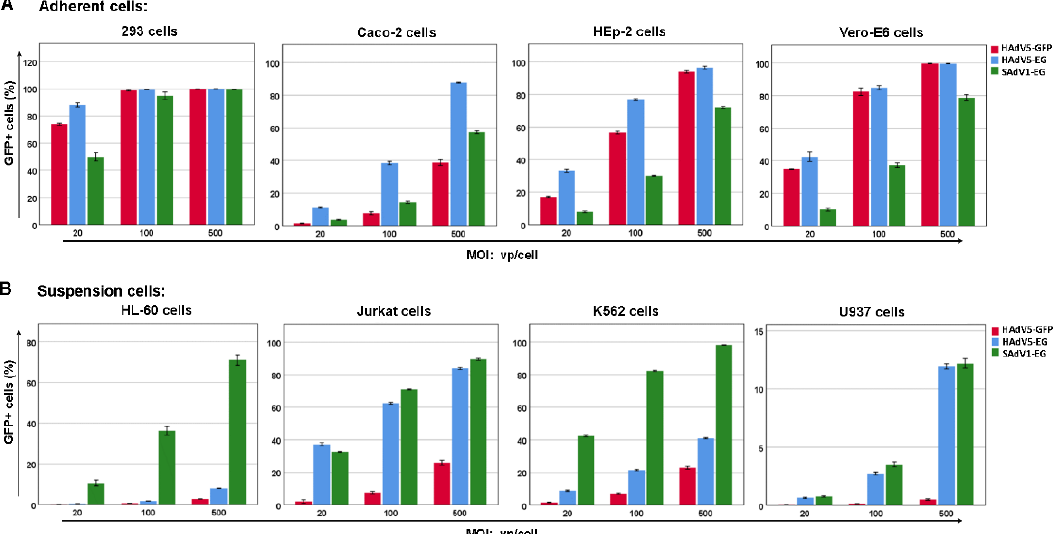
Figure 6. Gene transduction efficiency of SAdV1-EG on adherent ( A ) or suspension cell lines ( B ). Cells were infected with SAdV1-EG at an MOI of 20, 100, or 500 vp/cell. The percentage of GFP+ cells was determined by flow cytometry 2 days post infection. HAdV5-GFP and HAdV5-EG viruses served as controls, which were E1/E3-deleted HAdV-5 vectors and carried CMV promoter (HAdV5-GFP) or human EF1a promoter (HAdV5-EG) controlled GFP cassette, respectively.